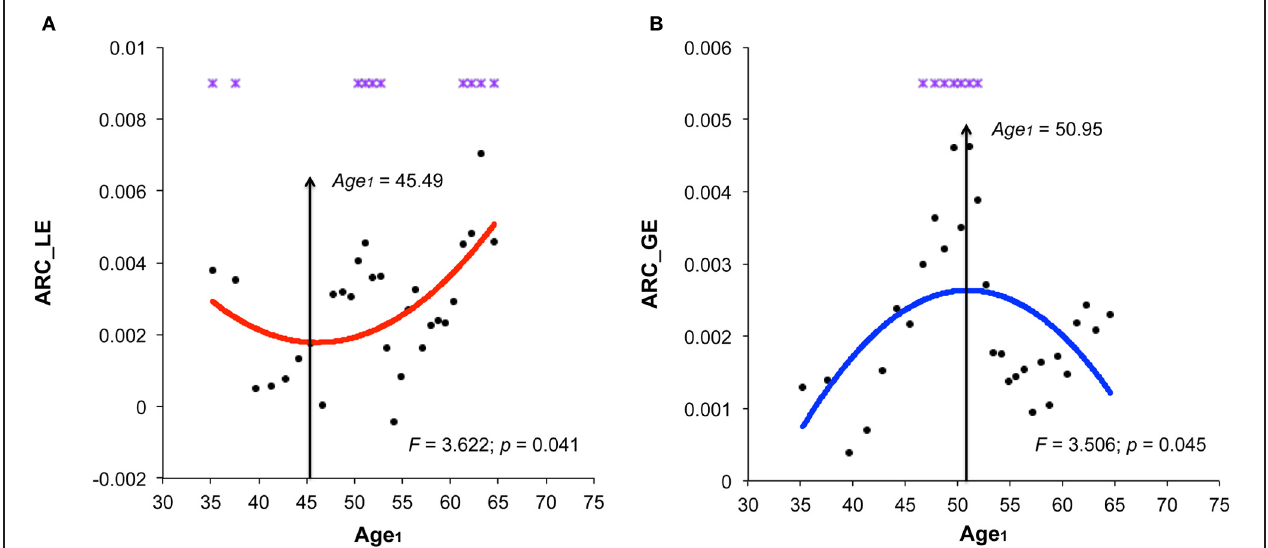
FIGURE 3 | Significant correlations between the annual rate of change in small-world efficiency and the baseline age. (A) Significant positive quadratic correlations between the annual rate of change in local efficiency ( ARC_LE ) and the baseline age (Age 1 ), peaked at the baseline age of 45.49 years. (B) Significant negative quadratic correlations between the